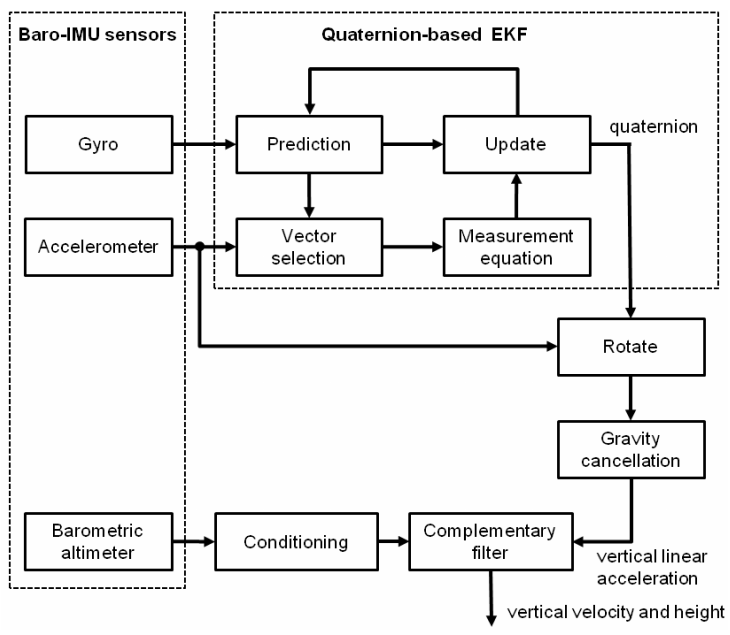
Figure 2. Block diagram of the sensor fusion method for estimating vertical velocity and height using baro-IMU sensor